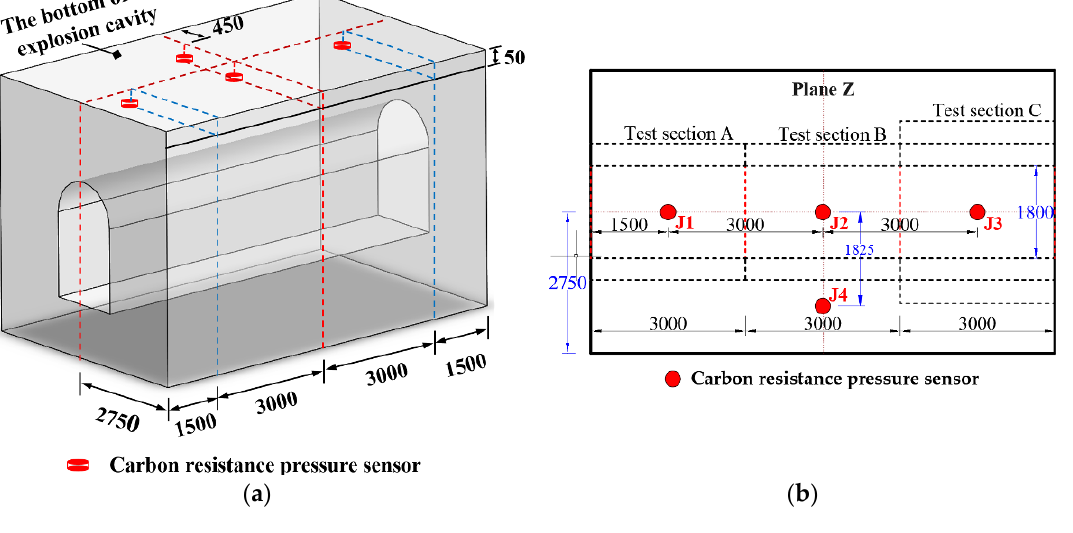
Figure 5. The transducer’s layout at the bottom of the explosion cavity (mm): ( a ) The spatial position diagram of the pressure sensors; ( b ) the top view of the plane Z.